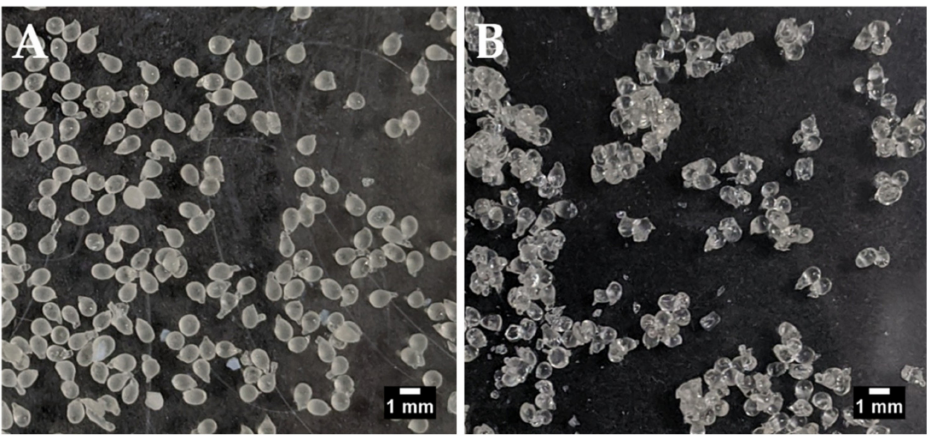
Figure 1. Manually-generated insulin-dWPI beads. ( A ) with Aerosil ® drying, ( B ) without Aerosil ® drying. Scale bars = 1 mm.